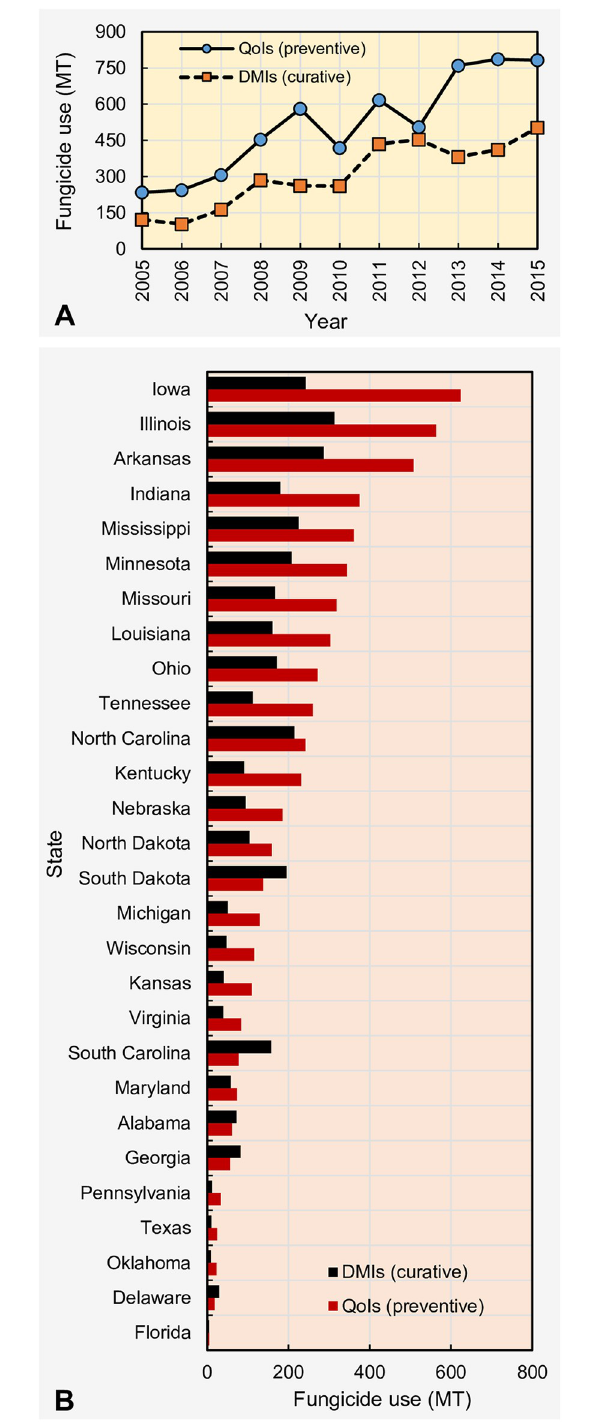
Fig 3. Temporal fluctuation (A) and state-wide variation (B) in the amount of preventive and curative foliar fungicide application use in the United States. Preventive fungicides = quinone outside inhibitors (QoIs) = ∑ azoxystrobin, fluoxastrobin, picoxystrobin, pyraclostrobin, and trifloxystrobin. Curative fungicides = demethylation inhibitors (DMIs) = ∑ cyproconazole, difenoconazole, flutriafol, propiconazole, prothioconazole, tebuconazole, and